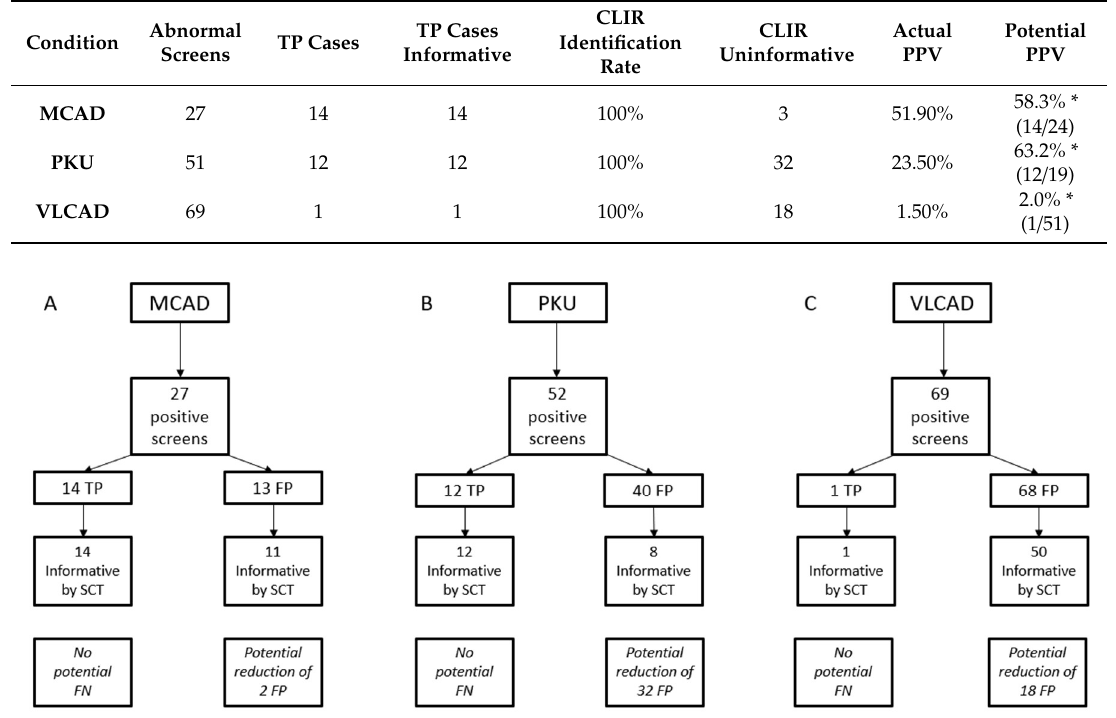
Figure 2. Summary of single condition tool (SCT) results for isolated screens for medium chain acyl-CoA dehydrogenase (MCAD) deficiency ( A ), phenylketonuria (PKU) ( B ), and VLCAD deficiency ( C ). Potential changes in false negative or FP results are what would have been achieved if all informative results were reported out, and all uninformative results were treated as normal.